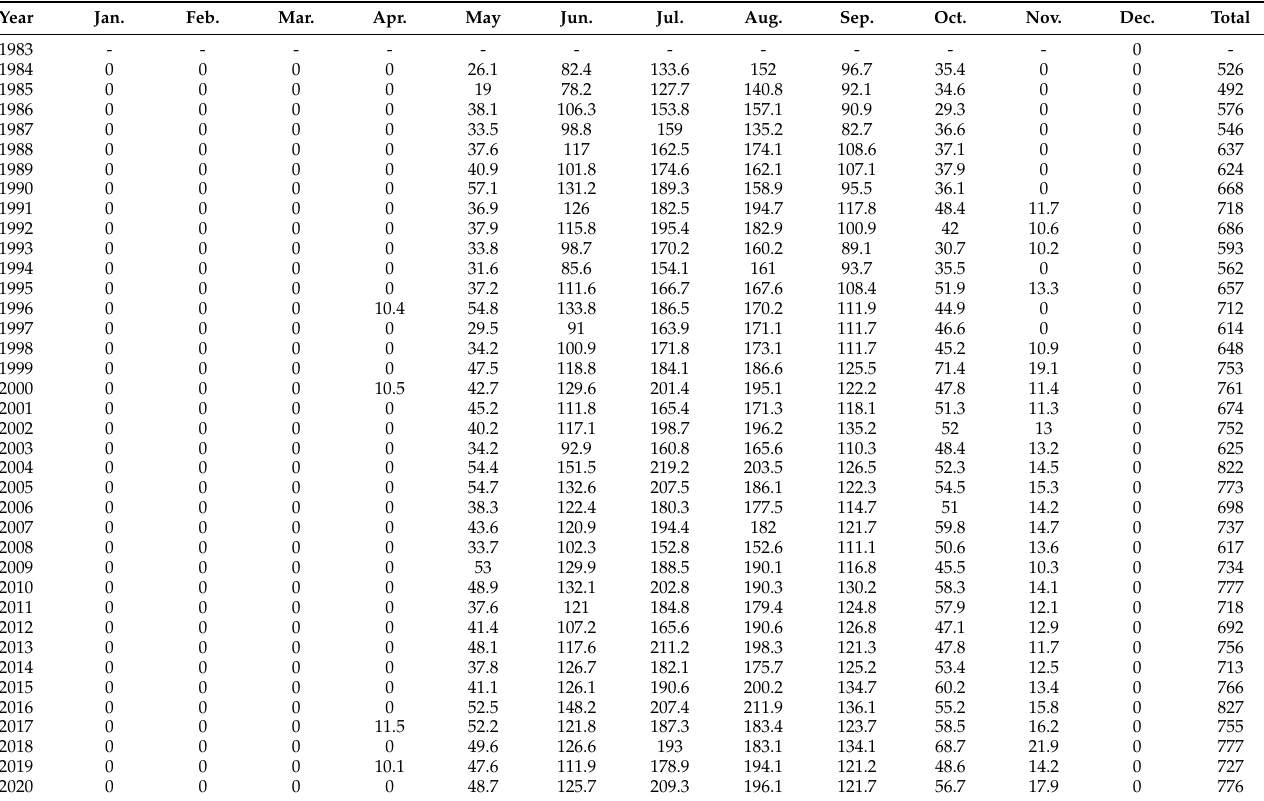
Table A1. Monthly rainfall forecasts (mm) in the Bani and Senegal River